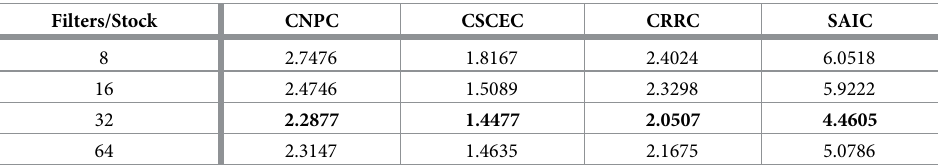
Table 5. MAPE value of common stock in convolution kernel with different number